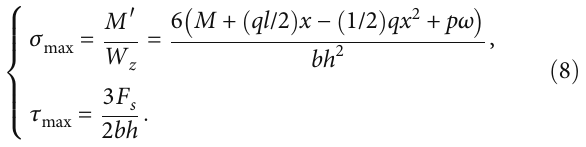
Figure 7: Schematic diagram of fracture tip expansion in horizontal direction of rock